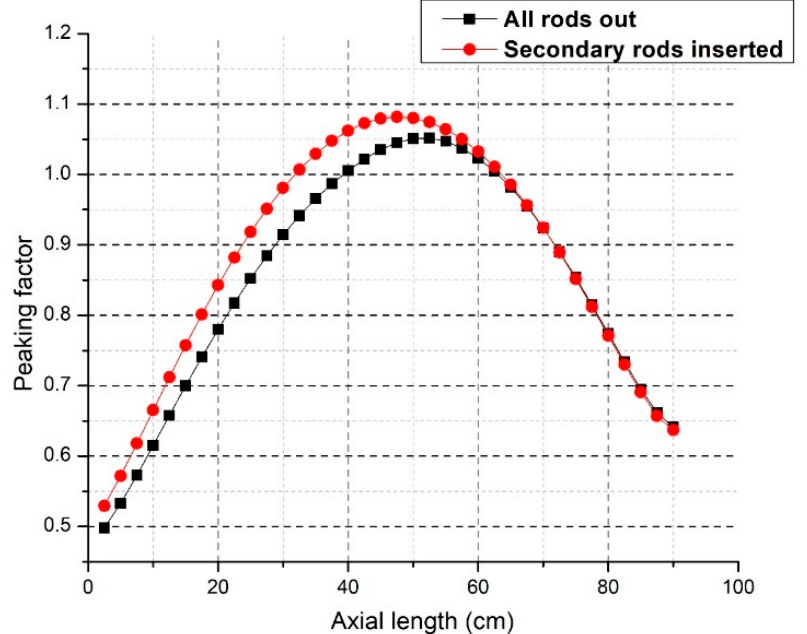
Figure 14. Change in axial power profile near the secondary assemblies when fully inserted at BOC.